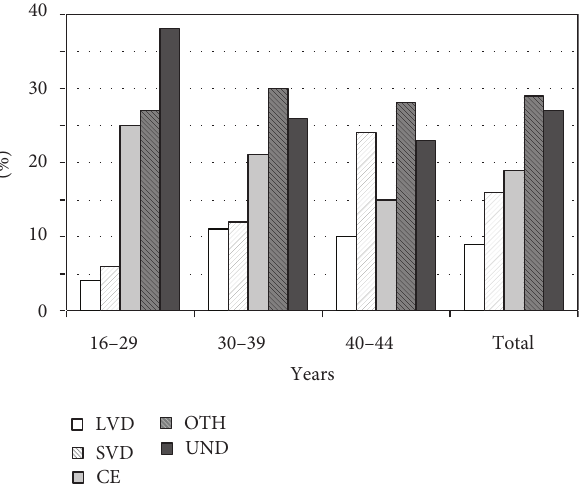
Figure 2: TOAST criteria stratified by age classes.